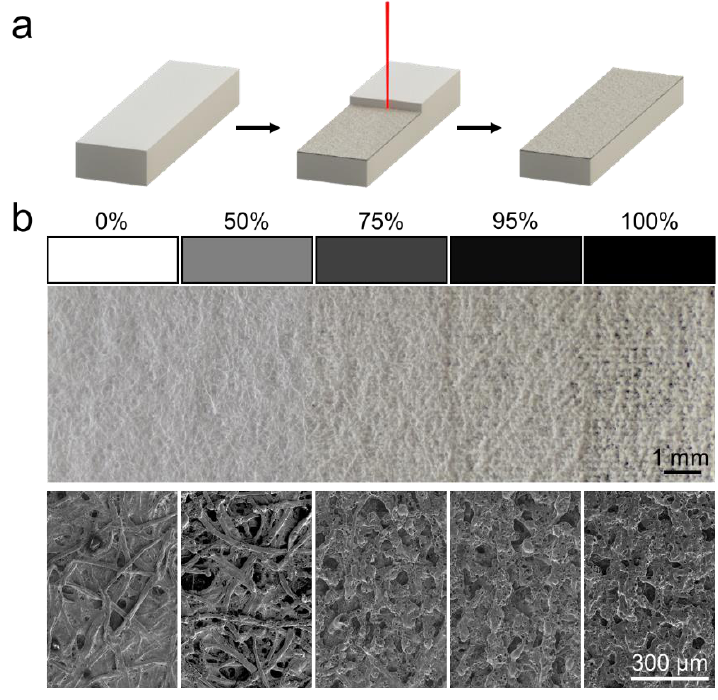
Figure 2. Laser-etched paper. ( a ) Schematic of the etching process. The etching process removes material from the top surface the paper. ( b ) Macro and SEM images of the etched paper surface. At the macro level, surface modification is not visible until 75%, but even at 50%, it is apparent that material has been removed from the surface in the SEM images.